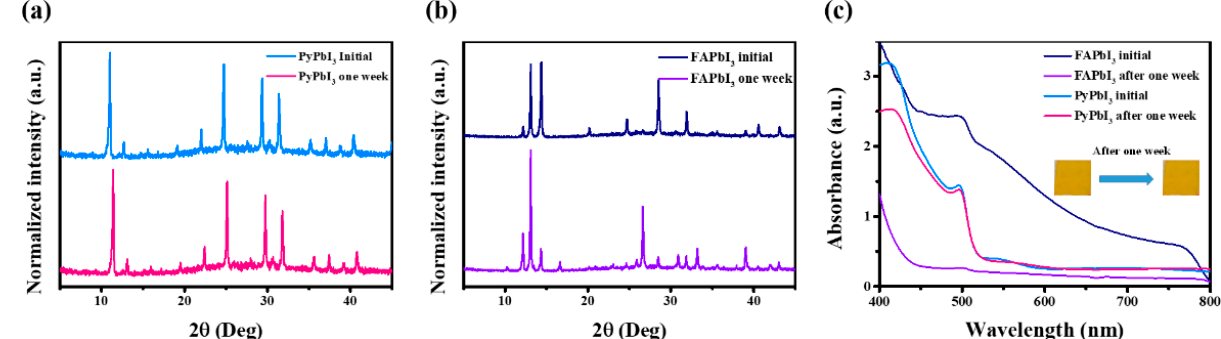
Figure 4. ( a ) XRD patterns of PyPbI 3 ( b ) and FAPbI 3 , and ( c ) UV absorption results of PyPbI 3 and FA-based perovskite before and after one week in ambient condition; inset shows the photograph of PyPbI 3 perovskite film before and after one week.